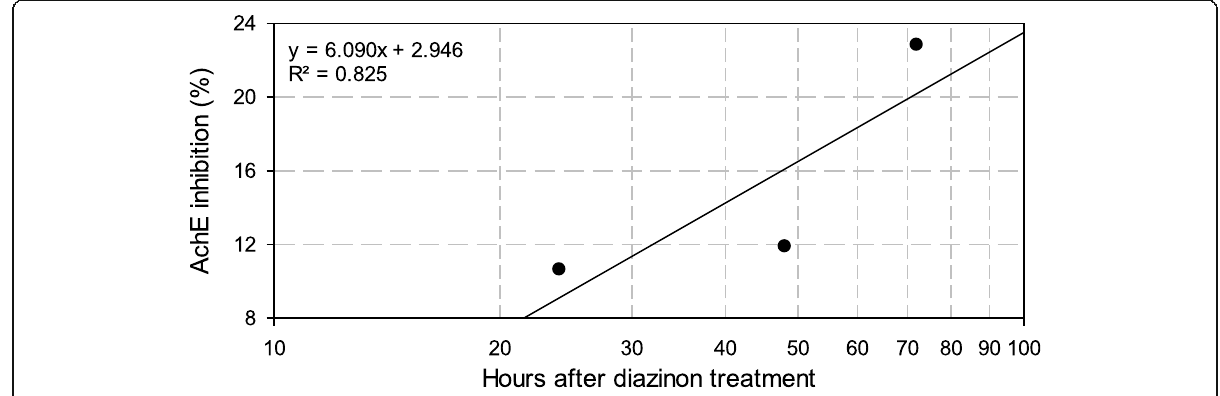
Fig. 2 Inhibition of AChE activity in Bactrocera zonata pupae treated with diazinon